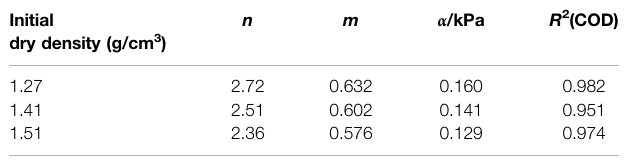
TABLE 5 | Fitting parameters of the Van Genuchten model for the SWCC of tailings at different initial dry densities. Initial dry density (g/cm 3 )